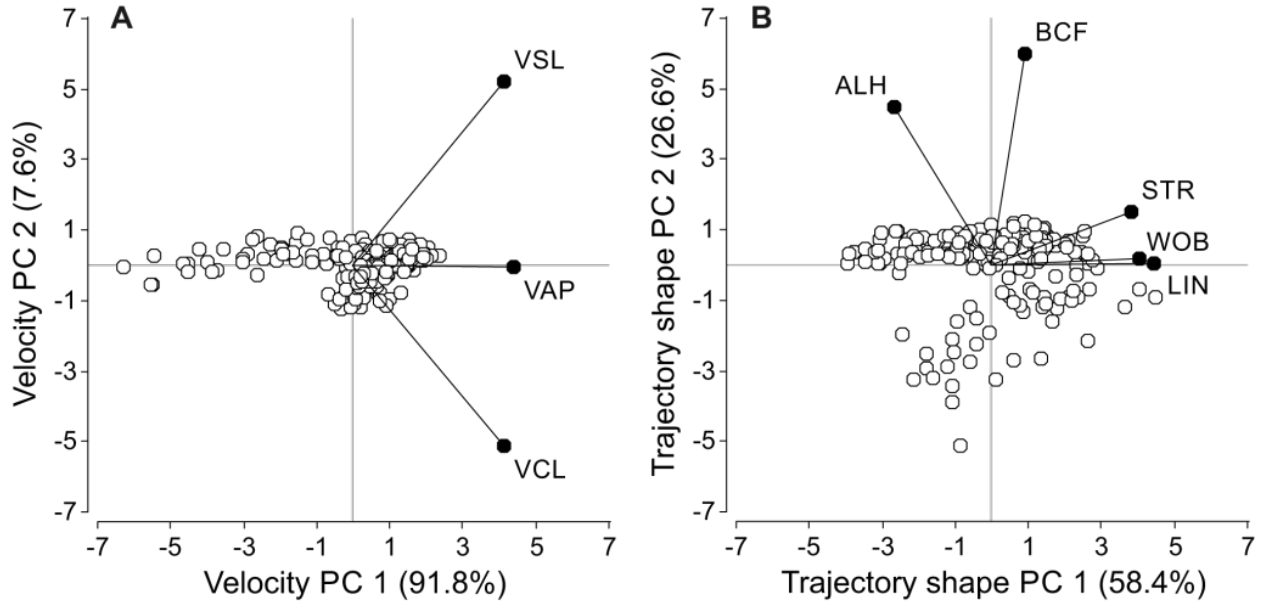
Figure 1. Biplots detailing the relationships between principal components of sperm velocity ( A ) and trajectory shape ( B ) and their constituent variables. Variable values were log 10 or arcsine transformed